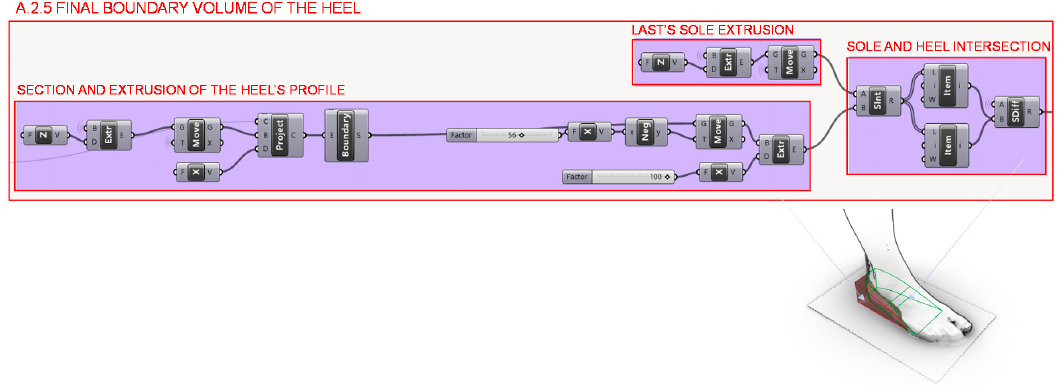
Figure 13. Programming structure definition developed to generate the final volume of the designed heel.